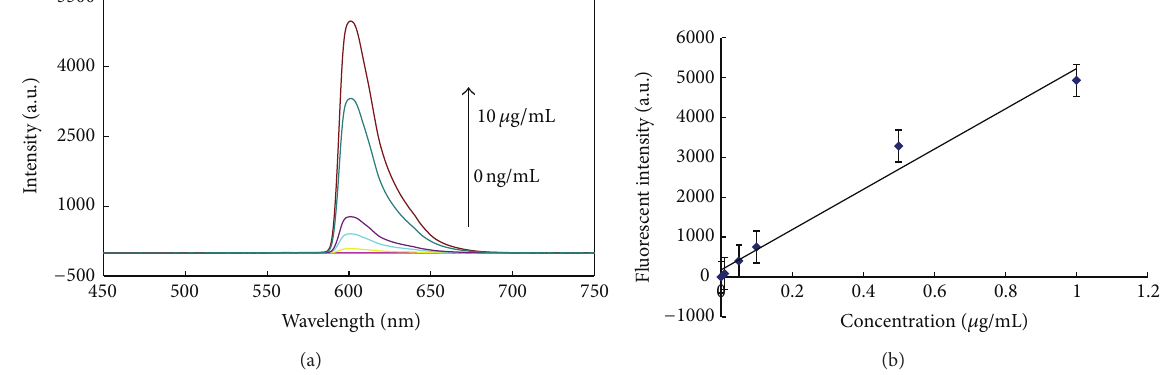
Figure 6: The Cy3 labelled antibody immunoassay and its work curve in this system. (a) The concentration of human IgG that was employed to the wells was 0ng/mL, 10ng/mL, 50 ng/mL, 100 ng/mL, 0.5 𝜇 g/mL, and 1 𝜇 g/mL. (b) Work curve of fluorescent intensity and human IgG. The tests were repeated for 3